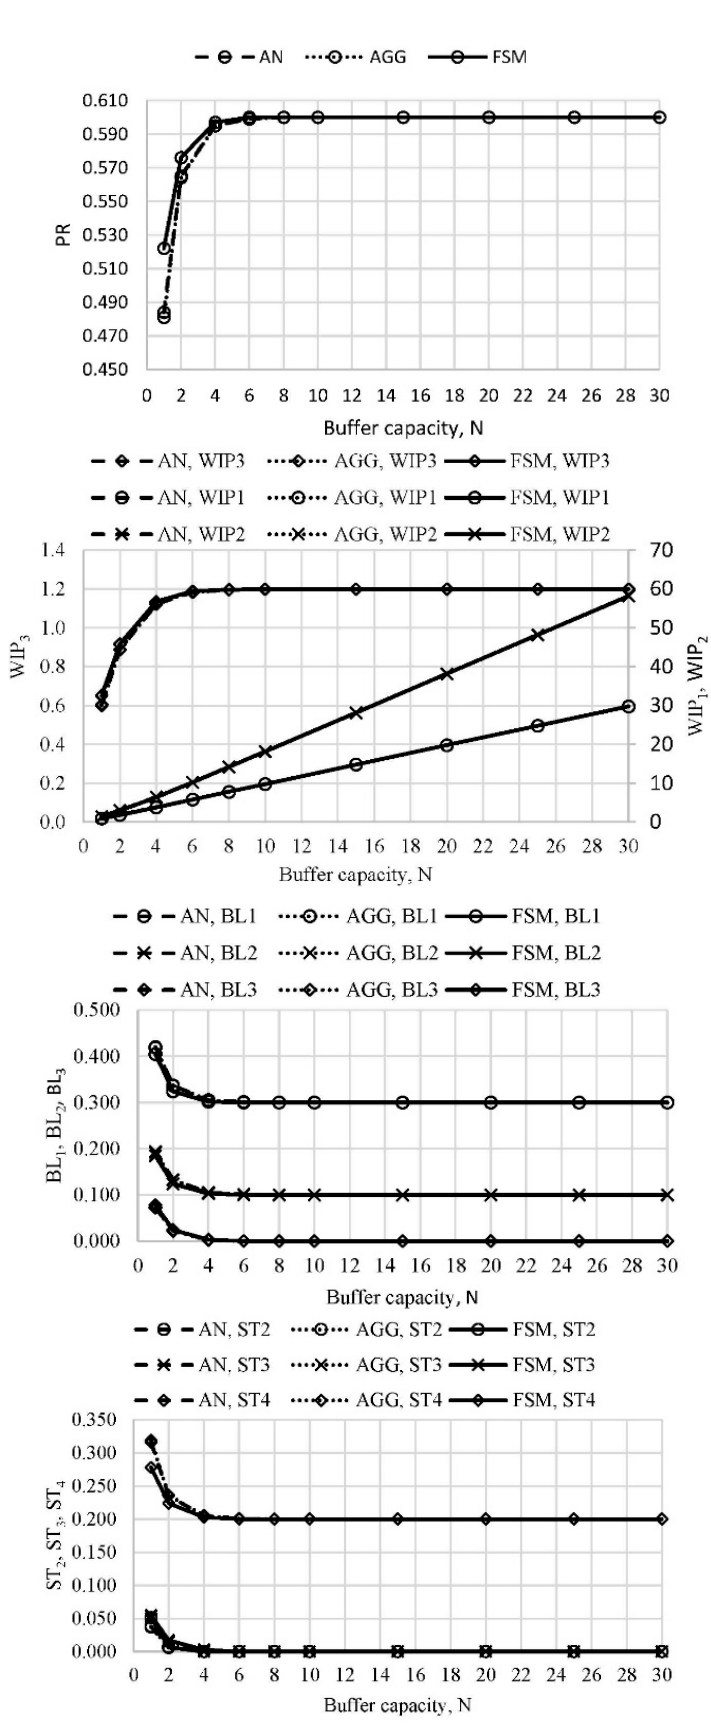
Figure 11. Performance measures of the line L 3C ( N 1 = N, N 2 = 2 N , N 3 = N ) (authors’ work).